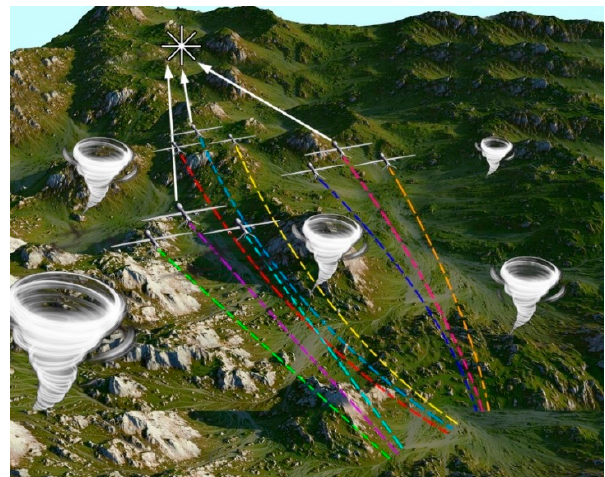
Figure 1. Mission Scenario.